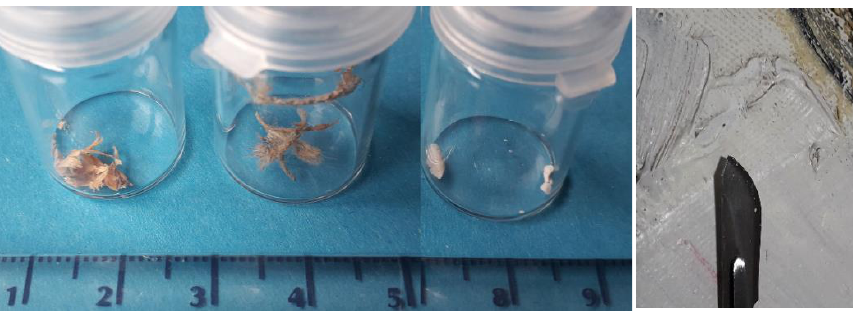
Figure 2. Left: samples of wood, canvas, and paint. Right : details of the paint layer. Figure 2. ( Left ): samples of wood, canvas, and paint. ( Right ): details of the paint layer. For radiocarbon dating, fiber and wood samples were pretreated with acid-base-acid washes, and the paint sample was only pretreated with acid due to its small size.